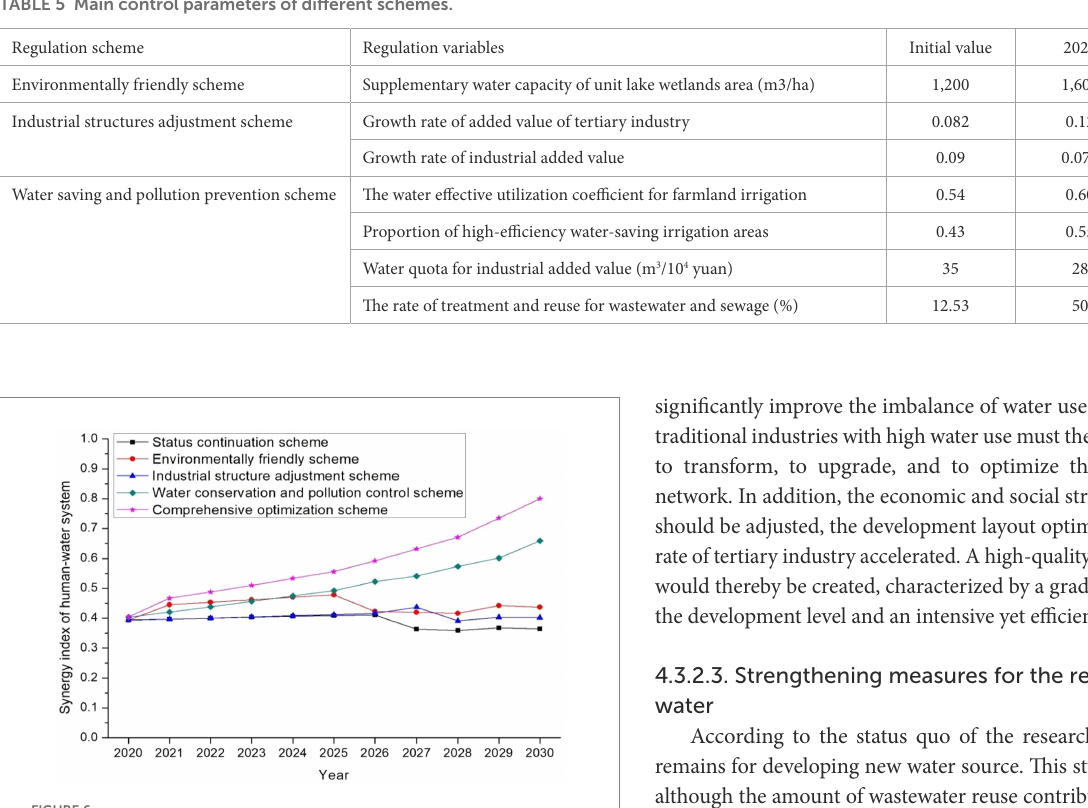
FIGURE 6 Synergy index of human-water system in different regulation schemes.